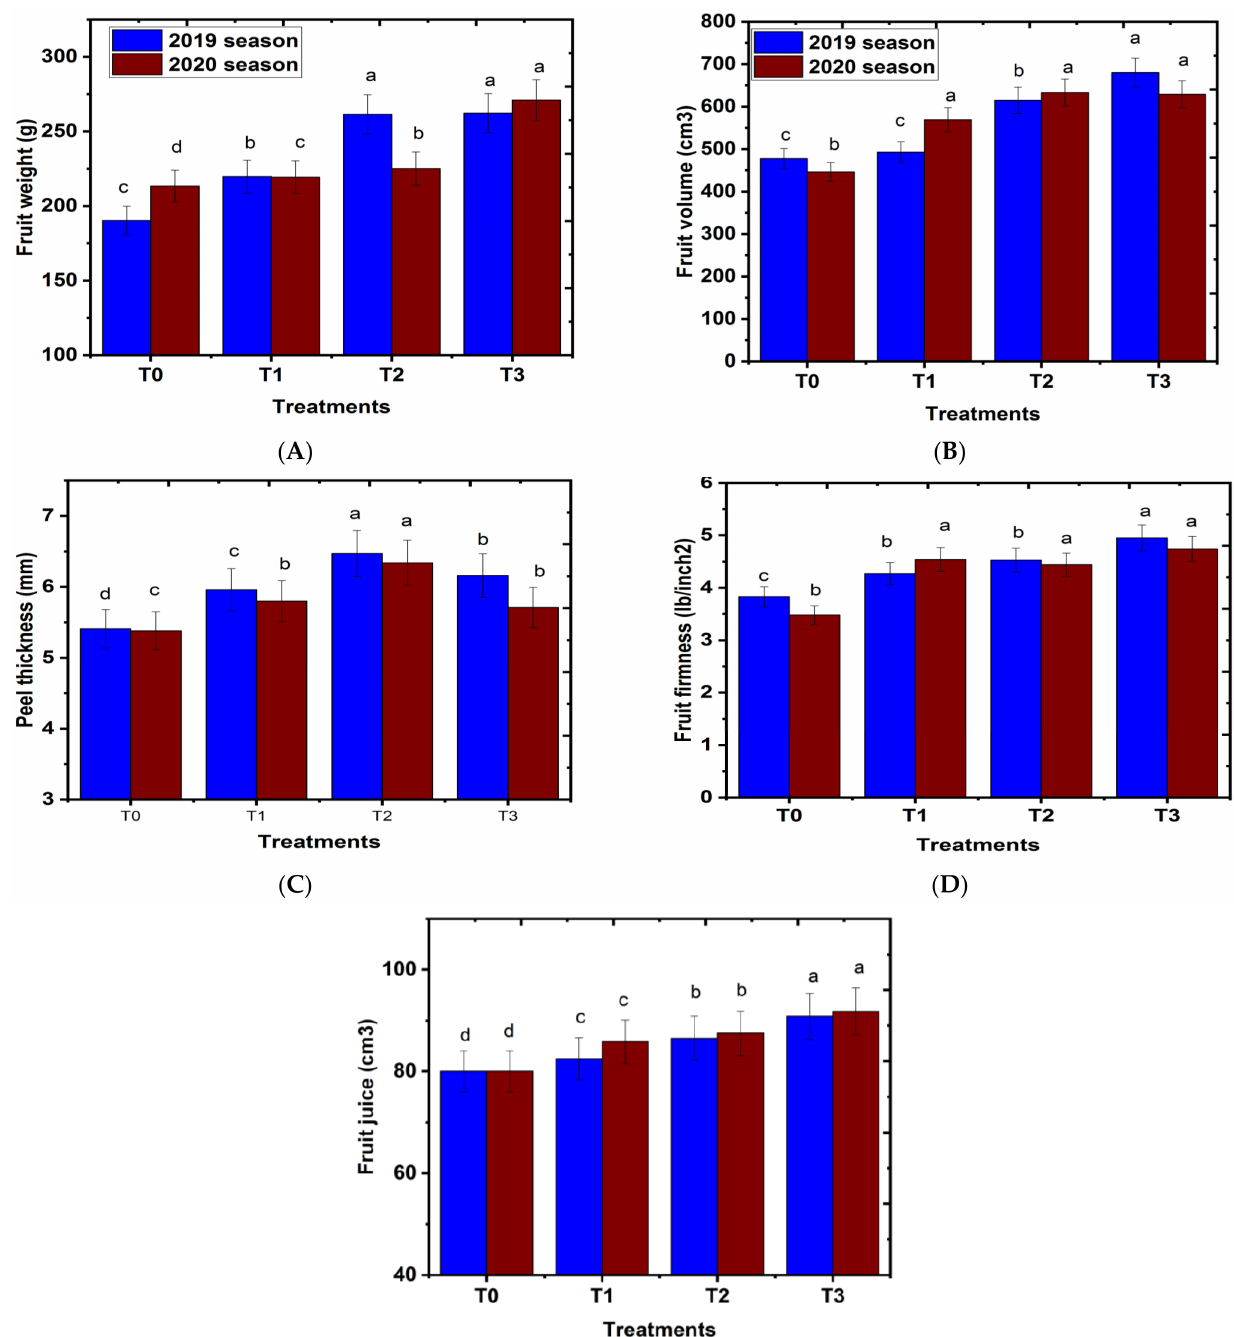
Figure 5. Effect of magnetic iron application on fruit physical properties of ‘Chinese’ mandarin trees during 2019 and 2020 seasons: ( A ) fruit weight, ( B ) fruit volume, ( C ) peel thickness, ( D ) fruit firmness(lb/inch 2 ) , and ( E ) fruit juice. T0: 0 g magnetic iron.tree −1 , T1: 250 g magnetic iron.tree −1 , T2: 500 g magnetic iron.tree −1 , and T3: 750 magnetic iron.tree −1 . Bars indicate mean values ± SE ( n = 9). Different letters above columns indicate significant differences among magnetic iron treatments at p = 0.05 according to Bartlett’s test.